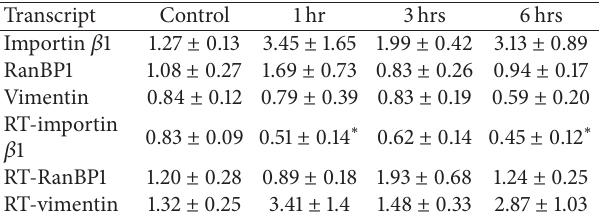
Table 3: Western blotting quantification and comparison. Untrans- formed data is provided for each transcript, as well as reciprocally transformed data for a given transcript, performed to normalize datasets prior to statistical analysis. ∗ indicates significant difference from